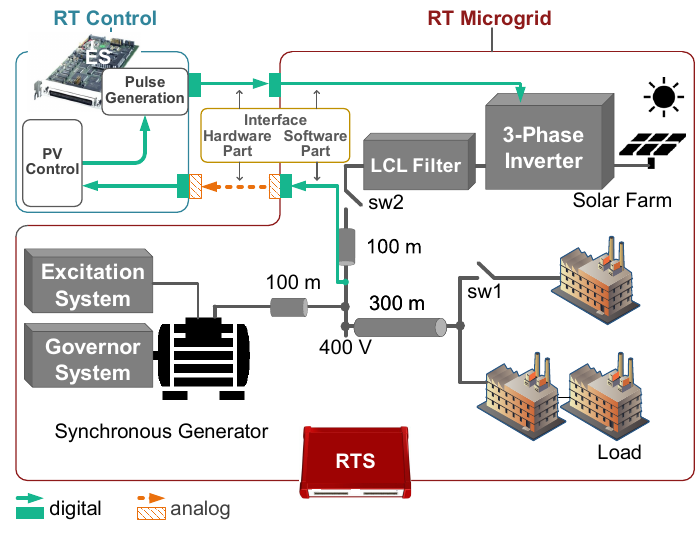
Figure 11. CHIL simulation structure of the